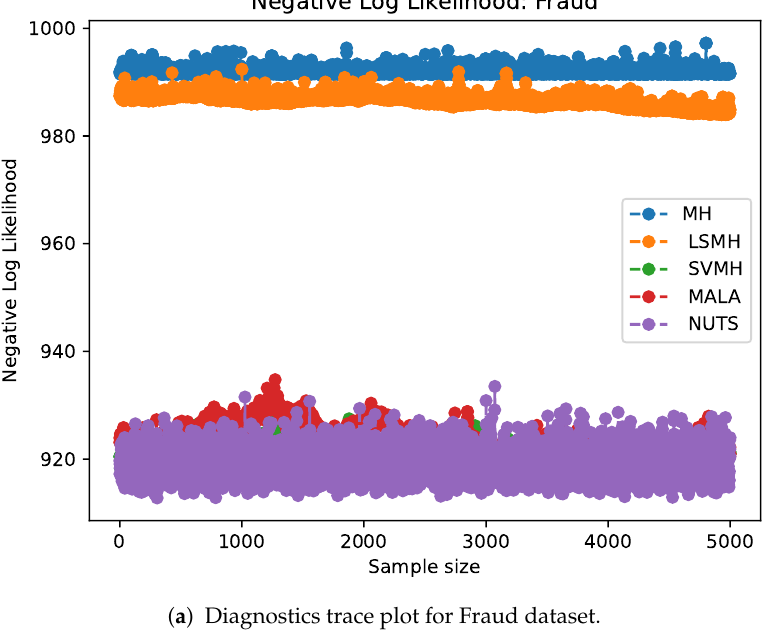
( a ) Diagnostics trace plot for Fraud dataset.